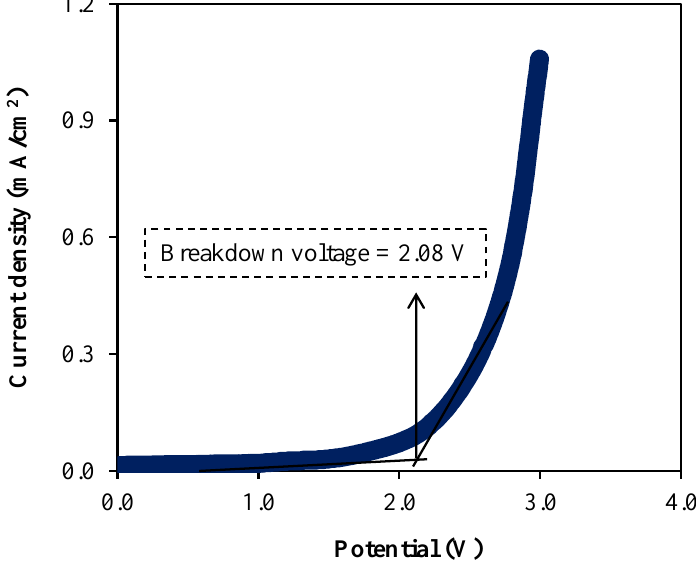
Figure 8. The plot of LSV curve for the A3 electrolyte.